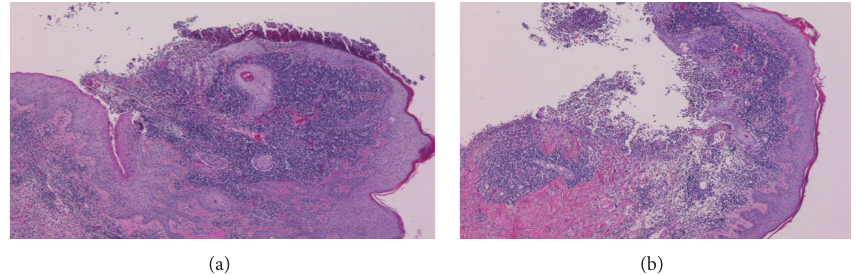
Figure 2: (a) and (b) (4x) Surface ulcerations with mixed acute and chronic inflammation and overlying fibrinopurulent exudate.